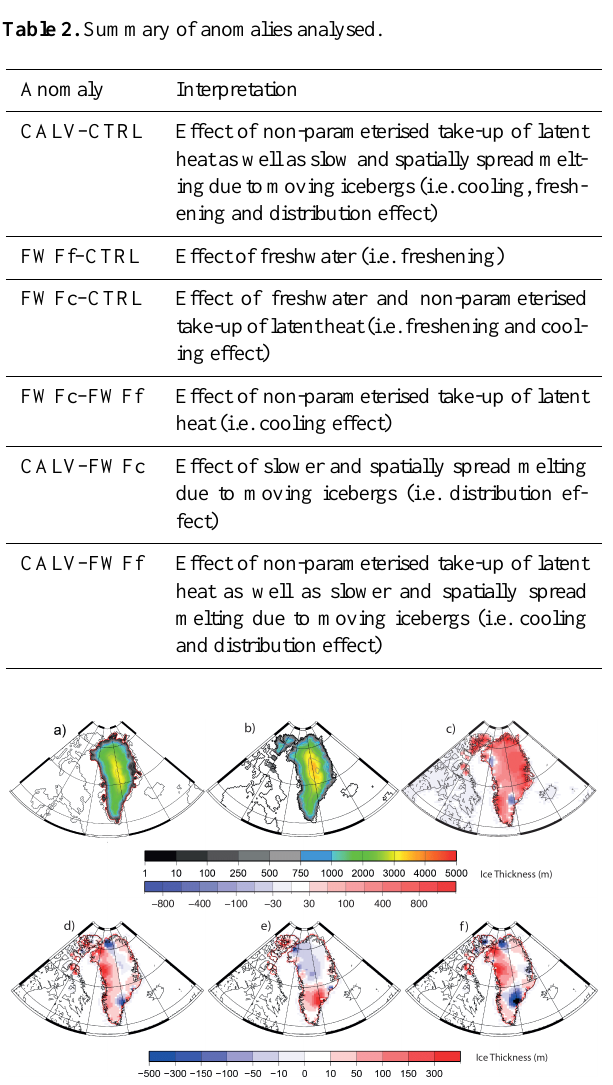
Figure 4. First row: ice-sheet thickness (m): (a) observed (Bam- ber et al., 2001), (b) CTRL run and (c) difference CTRL–observed; second row displays the differences (d) CALV–CTRL, (e) CALV– FWFf and (f) FWFf–CTRL (non-linear colour scheme).